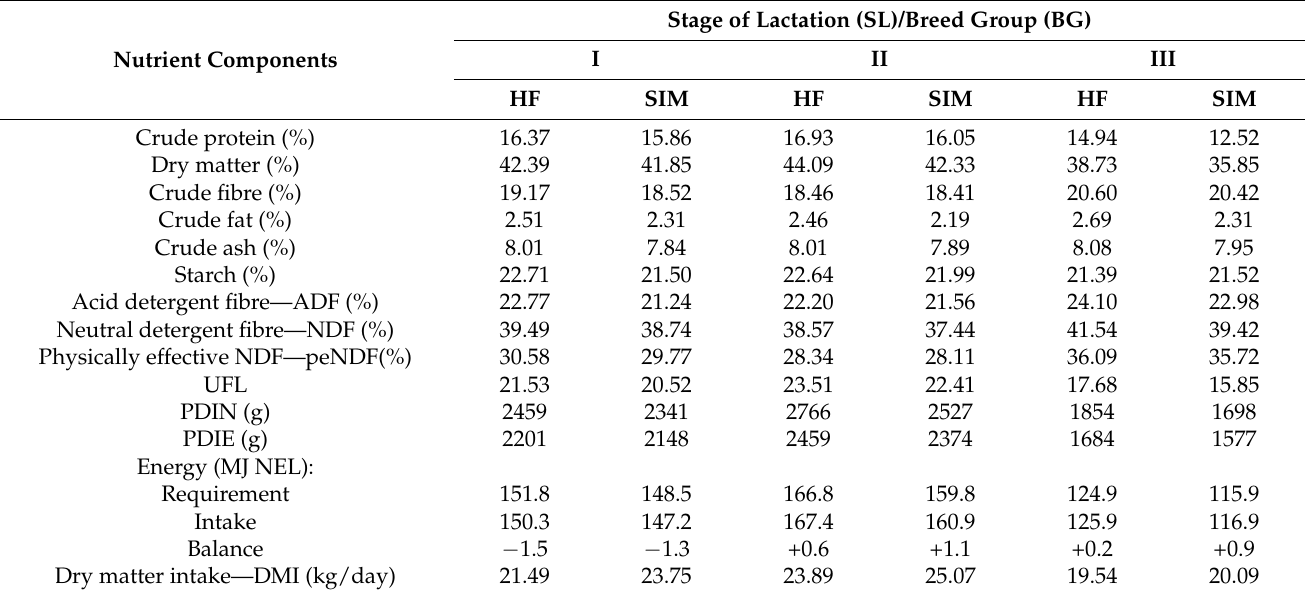
Table 1. Chemical components and balancing of the diet in each stage of lactation and breed group (day/cows). Stage of Lactation (SL)/Breed Group (BG) Nutrient Components